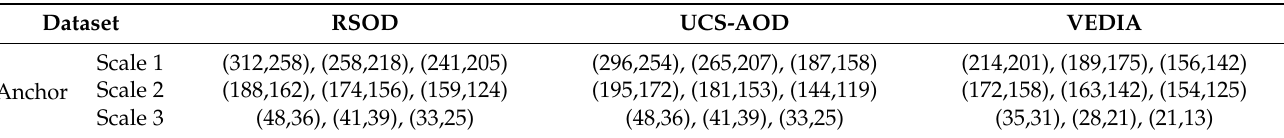
Table 6. The sizes of anchor boxes for RSOD, UCS-AOD, and VEDIA dataset.